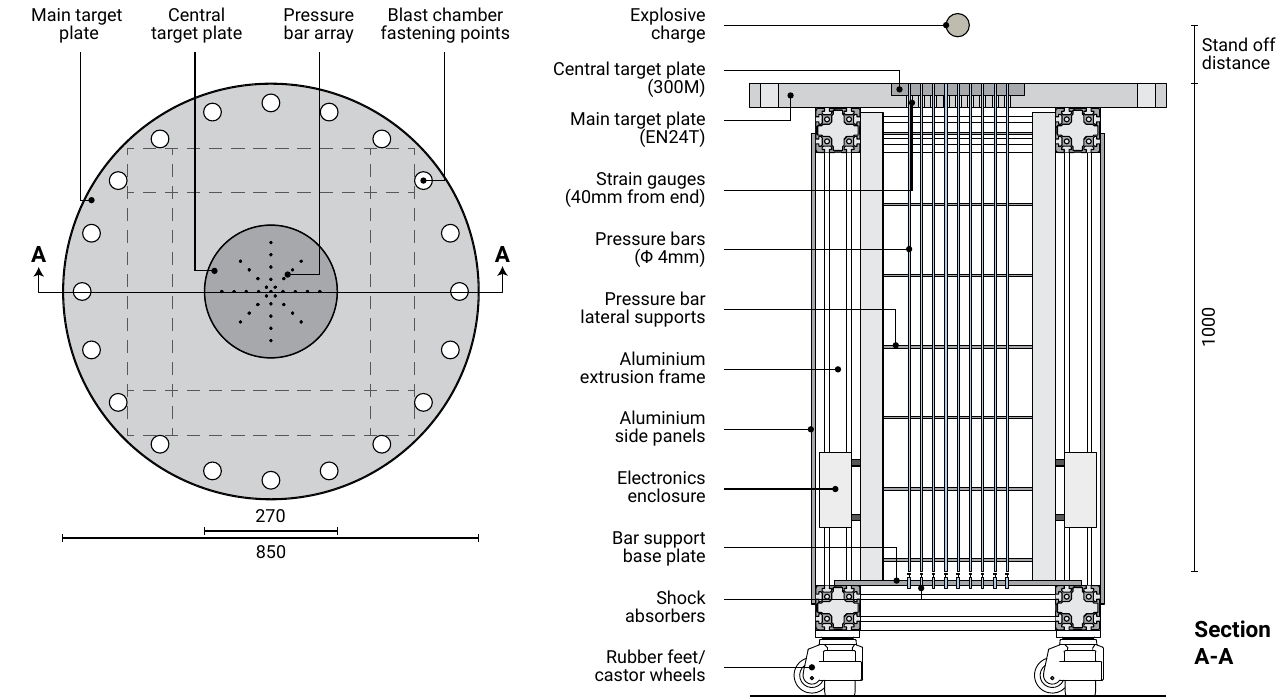
Figure 2. MaCE near-field facility in plan view and section. Dimensions are in